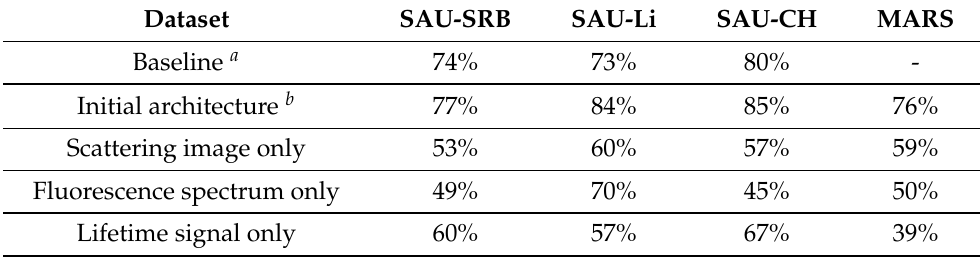
Table 5. Model performance